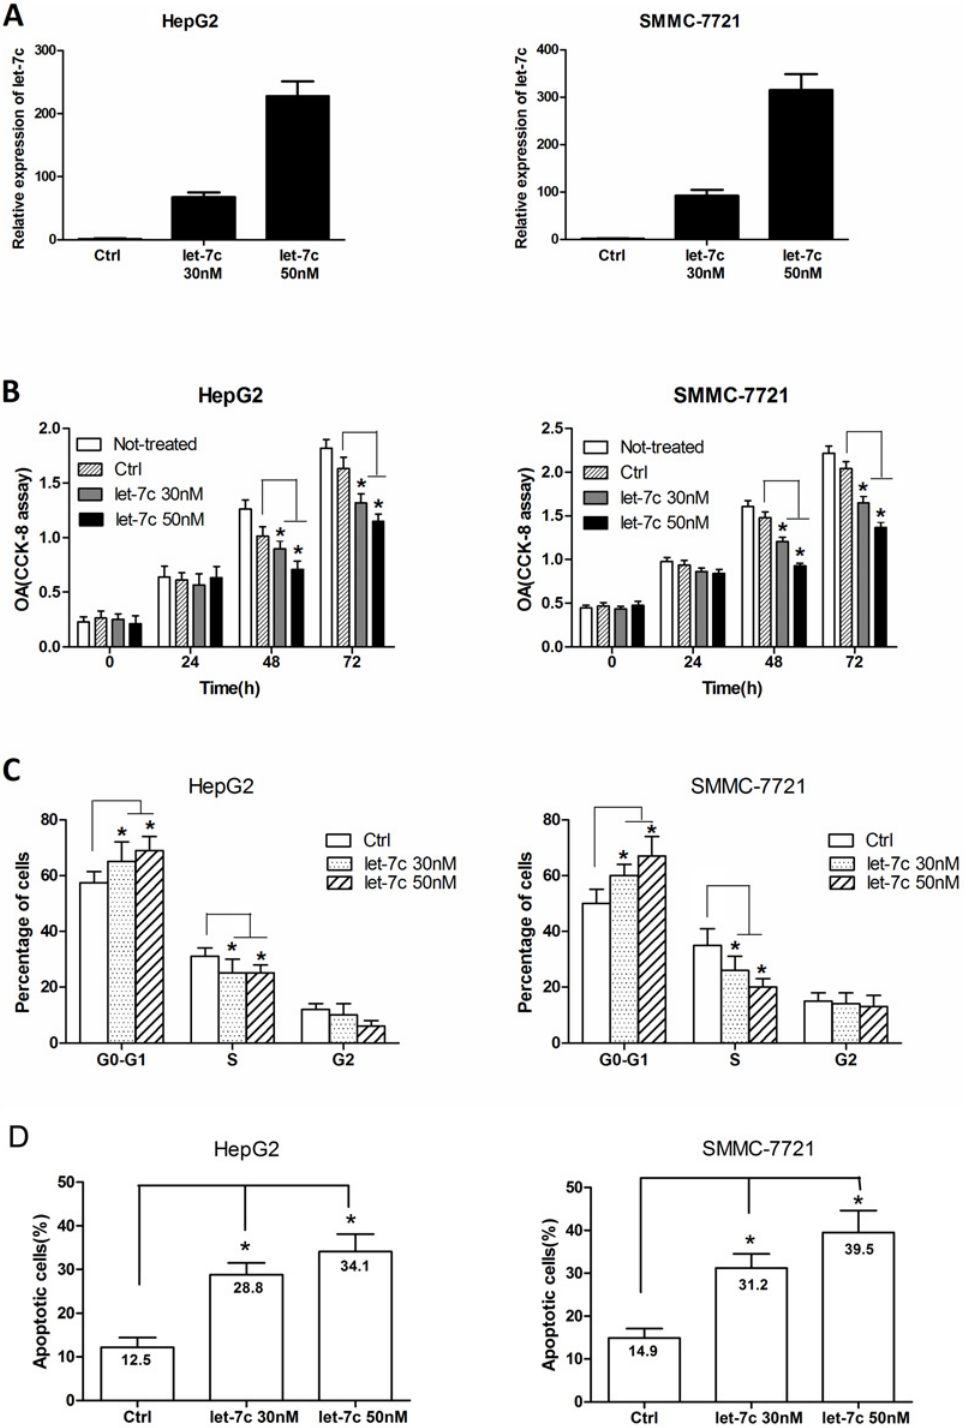
Fig 2. Let-7c inhibits HCC cell proliferation, induces cell apoptosis and induces G1 cell cycle arrest in vitro. (A) HepG2 and SMMC-7721 HCC cells were transfected with the let-7c agomir at a final concentration of 30 or 50 nM. Expression of let-7c was determined using quantitative real-time PCR 48 h post-transfection. (B-D) HepG2 and SMMC-7721 HCC cells were transfected as in (A). At the indicated time points post transfection, the cell growth rate was evaluated using the CCK-8 assay (B). Cells were stained using propidium iodide (PI) and Annexin V 72 h post transfection and analyzed by FACS. Annexin V-positive cells were regarded as apoptotic cells (D) and the cell cycle distribution was calculated (C).